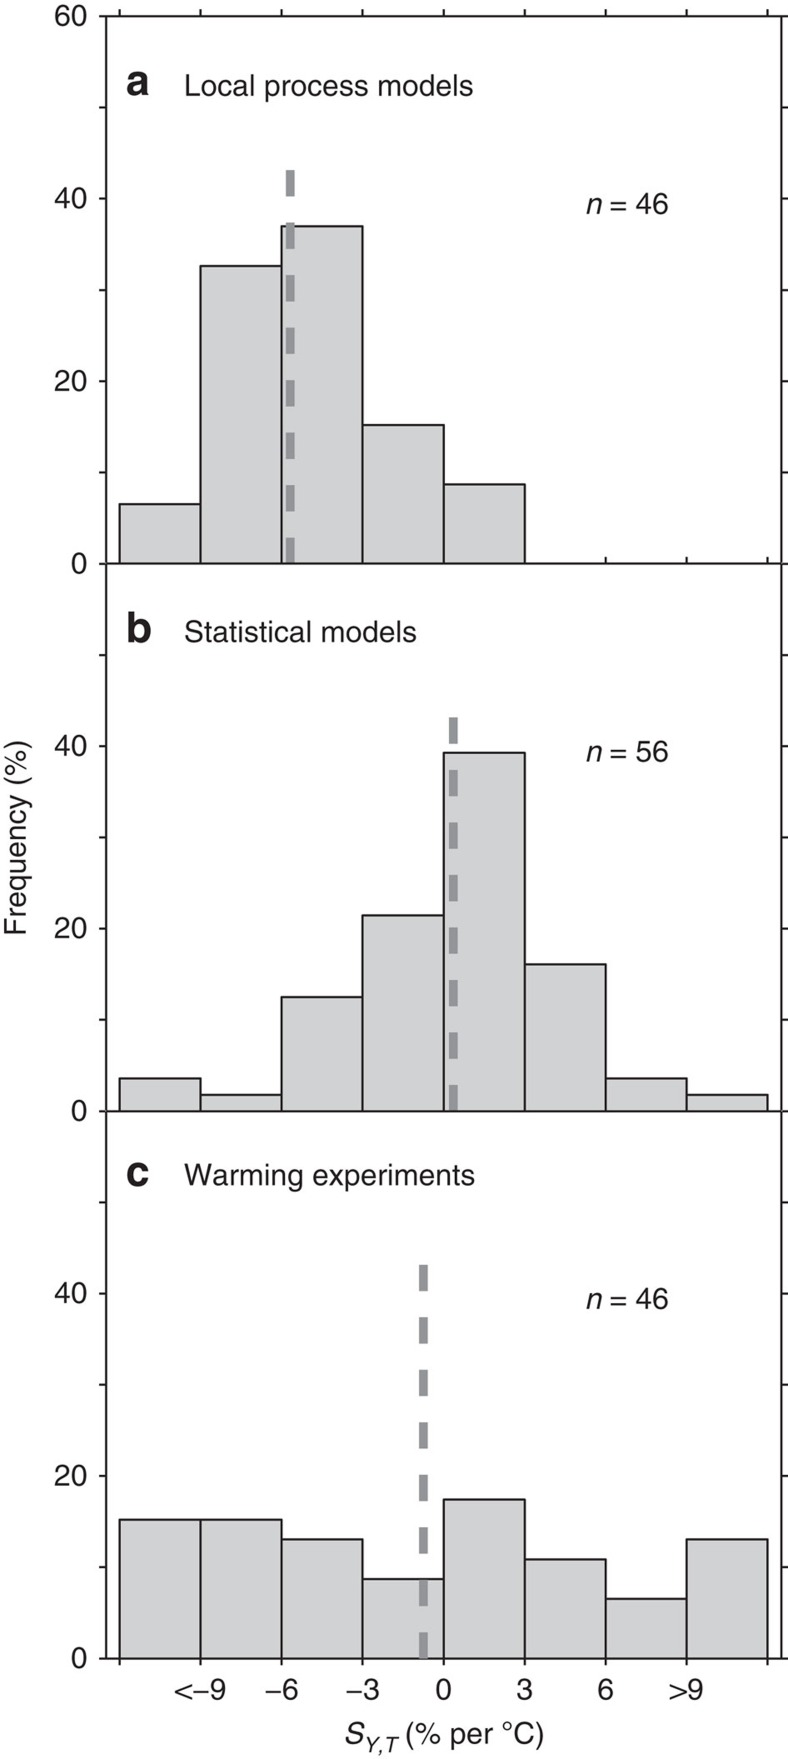
Histograms of SY,T derived from different approaches.(a) local process models. (b) statistical models. (c) Field warming experiments. The dotted line refers to the average SY,T of each approach and the numbers in the figure give the sample size.